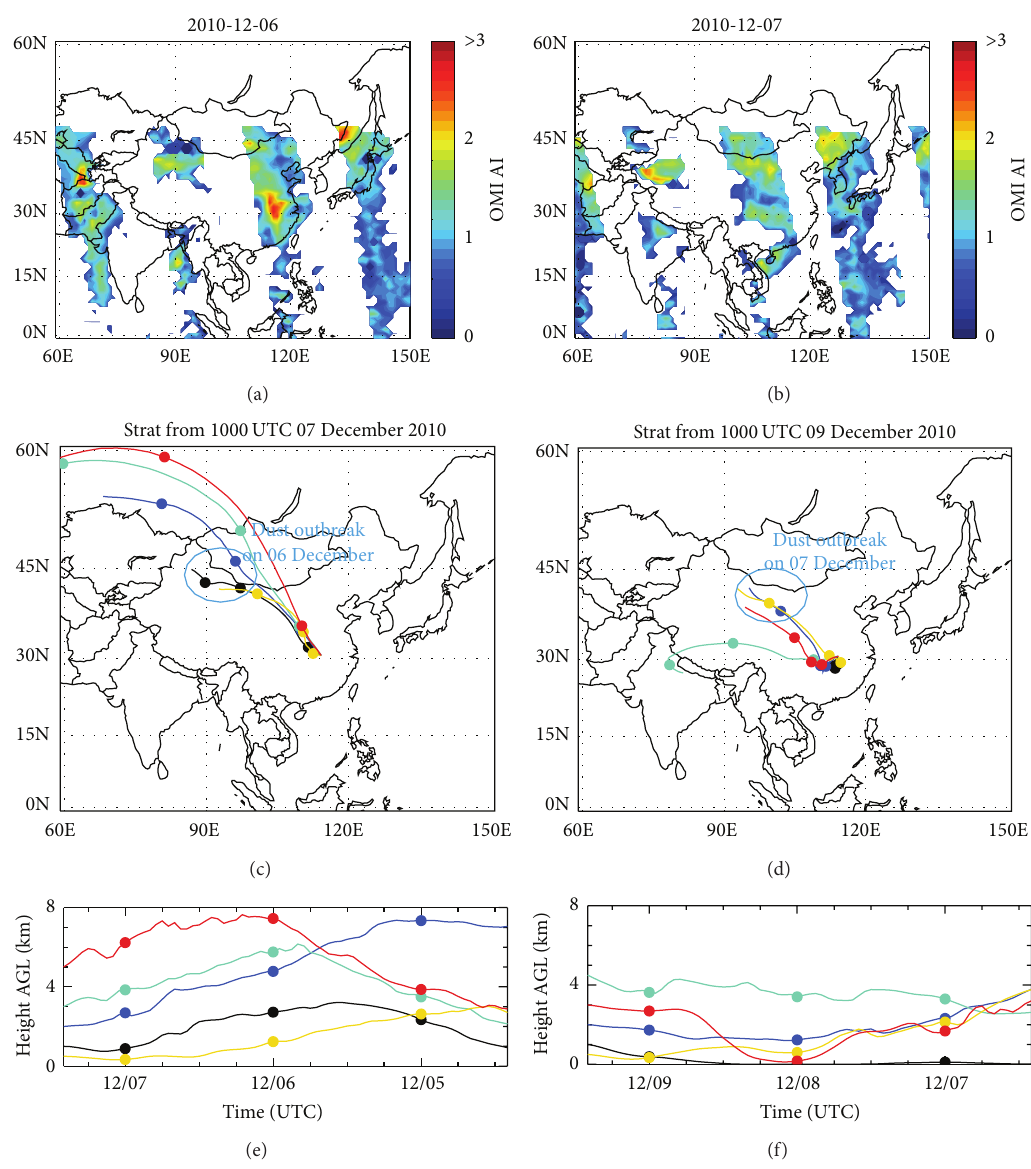
Figure 7: Aura OMI Aerosol Index (AI) distribution over East Asia on (a) 6 December 2010 and (b) 7 December 2010. Three-day back- calculated trajectories starting at Wuhan (30.5 ∘ N, 114.4 ∘ E) from 1000UTC on (c) 07 December 2010 (at 0.5 km, 1km, 2 km, 3km, and 5km) and (d) 09 December 2010 (at 0.5 km, 1km, 2km, 3 km, and 4.5 km), using the HYSPLIT model. The time-height display for the calculation of (c) and (d) is shown in (e) and (f),